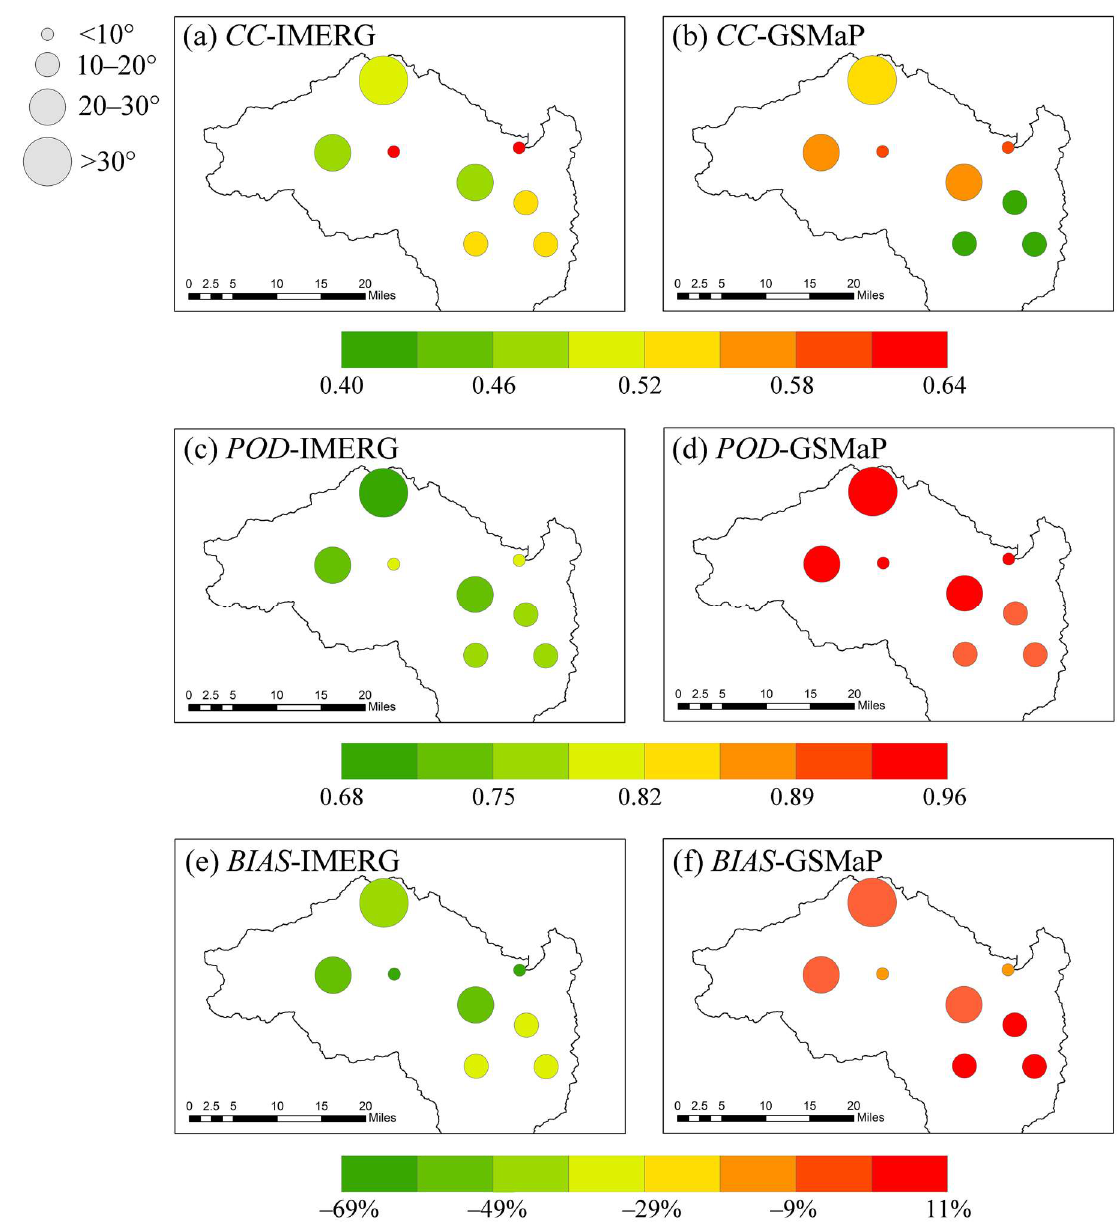
Figure 7. The correlations of the performance of IMREG and GSMaP with slope. ( a , b ) CC ; ( c , d ) POD ; ( e , f ) BIAS .